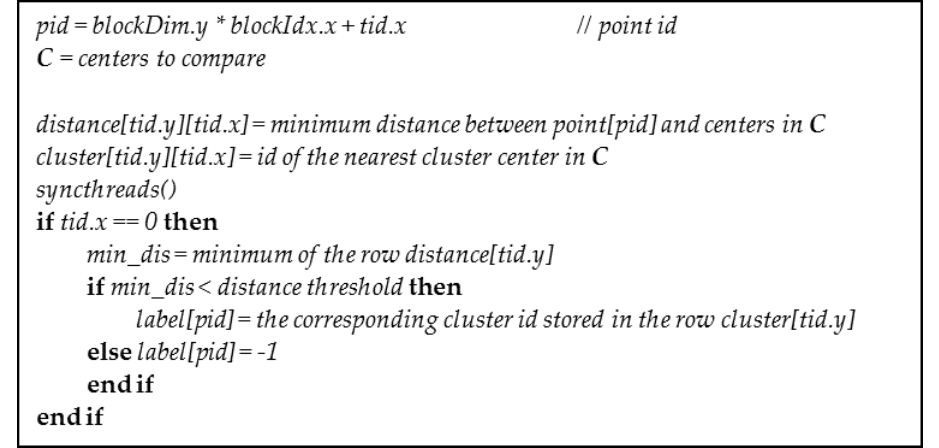
Figure 2. The pseudo code of GPU kernel for parallel clustering.